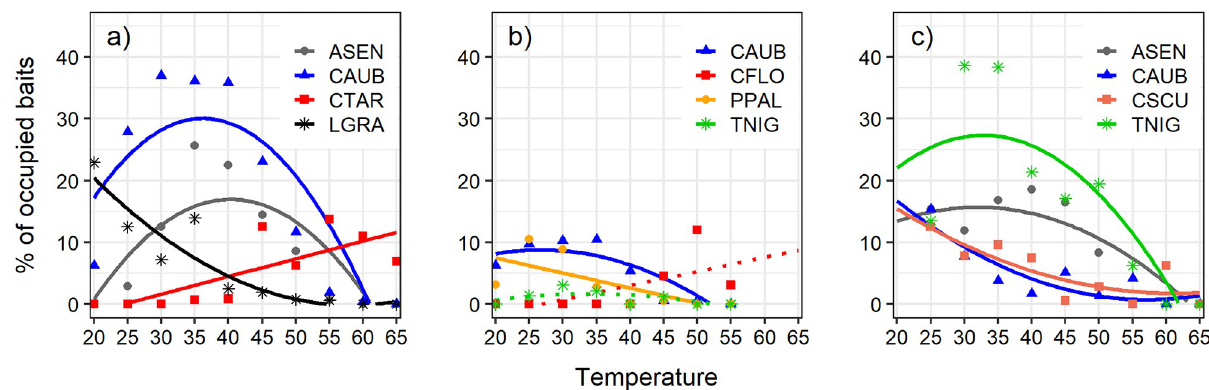
Fig 5. Linear or quadratic fit of the effect of temperature on bait occupation for the four most abundant species in each habitat: (a) Dry scrubland, (b) Savin forest and (c) Pine forest. Species abbreviations: ASEN ( Aphaenogaster senilis ), CFLO ( Cataglyphis floricola ), CTAR ( Cataglyphis tartessica ), CAUB ( Crematogaster auberti ), CSCU ( Crematogaster scutellaris ), LGRA ( Lasius grandis ), PPAL ( Pheidole pallidula ) and TNIG ( Tapinoma cf. nigerrimum ). Significant fits are shown by a solid line, not significant fits with a dotted line (S2 Appendix).